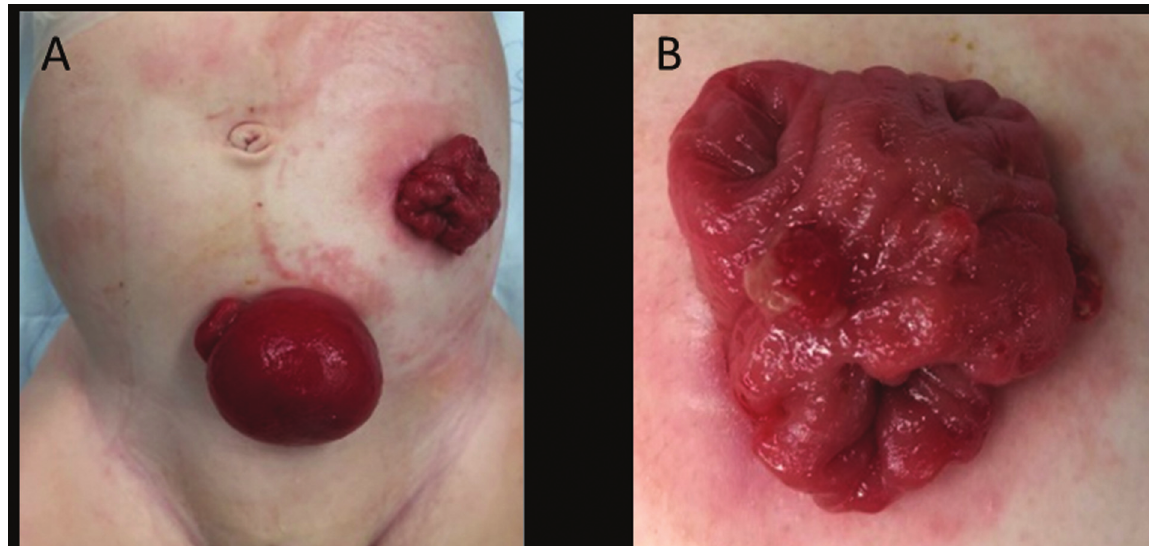
Fig. 1 Colostomy and prolapse mucus fi stula ( A ). Three distinct lumens of the colostomy ( B ).